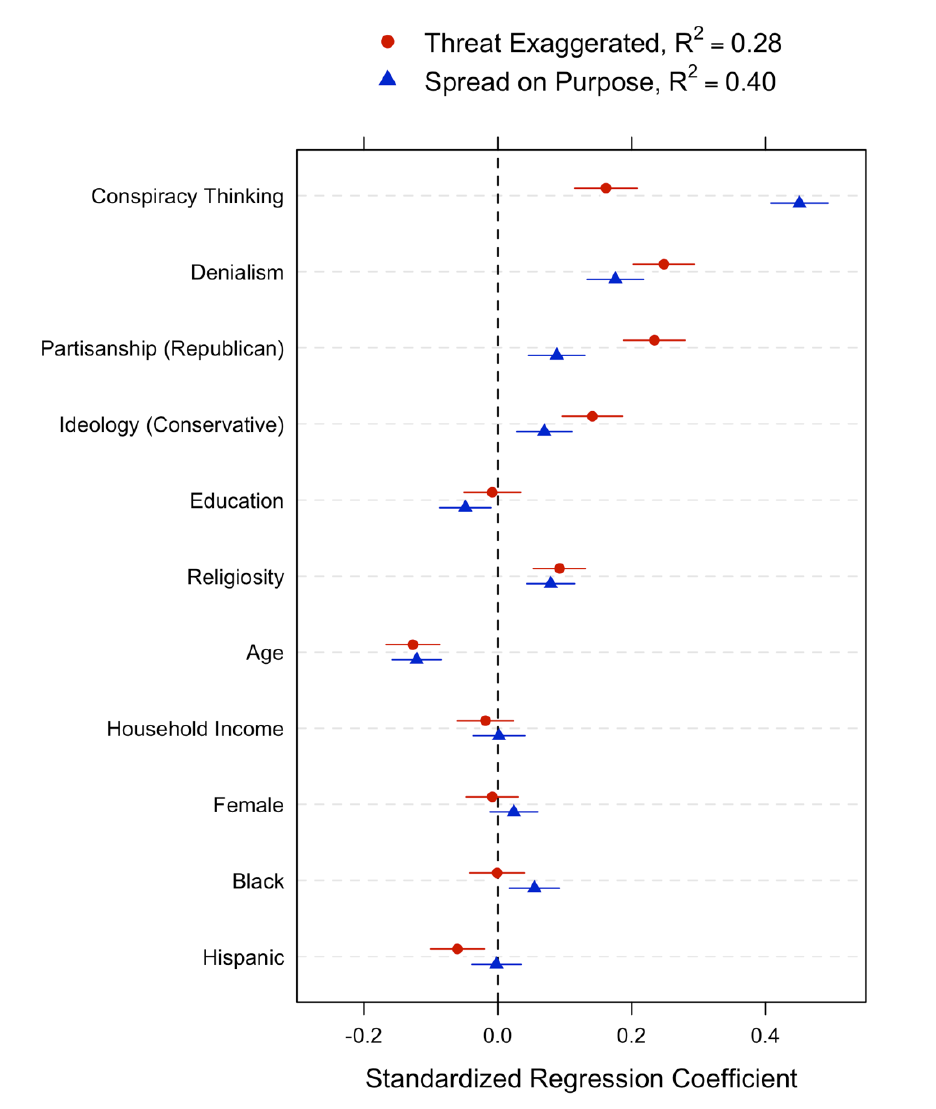
Figure 2. Predictors of COVID-19 conspiracy beliefs. Standardized ordinary least squares (OLS) regression coefficients, with 95% confidence intervals where dependent variables are beliefs in COVID-19 conspiracy theories. The larger the absolute value of the coefficient (i.e., the farther a given plotting symbol is to the left or right or the dashed line, 0), the stronger the relationship between the independent variable (on the left) and COVID-19 conspiracy beliefs. n=2,022 for both